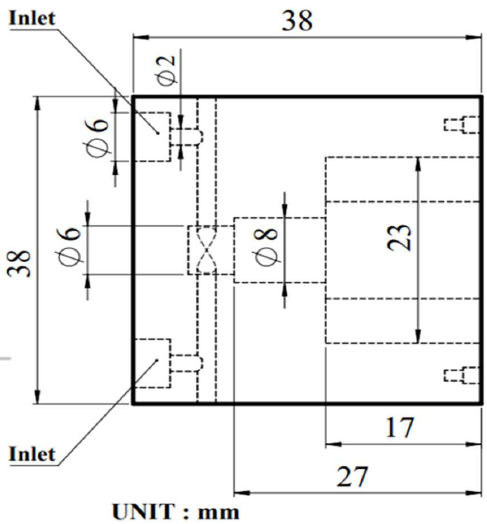
Figure 2. Horizontal vortex combustor dimensions.